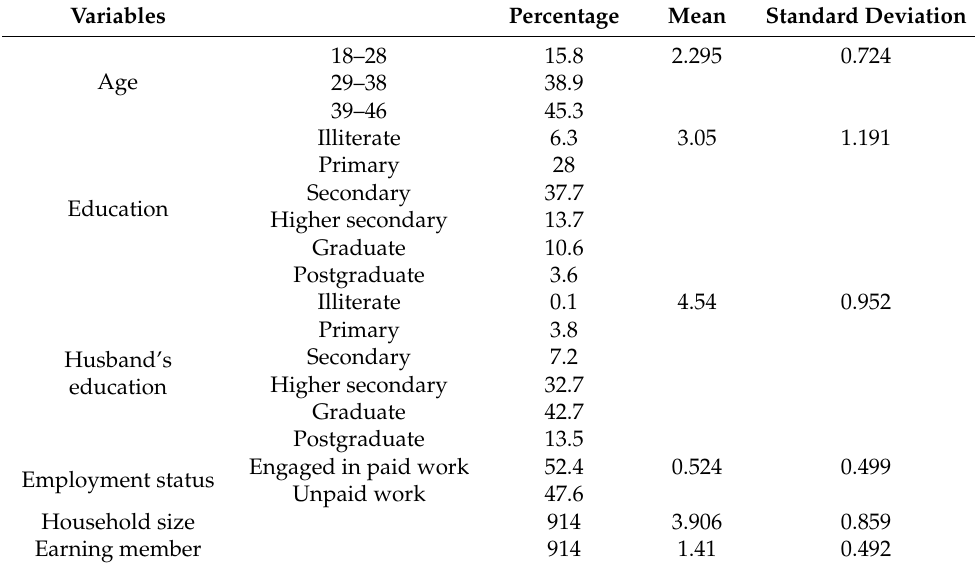
Table 2. Socio-demographic